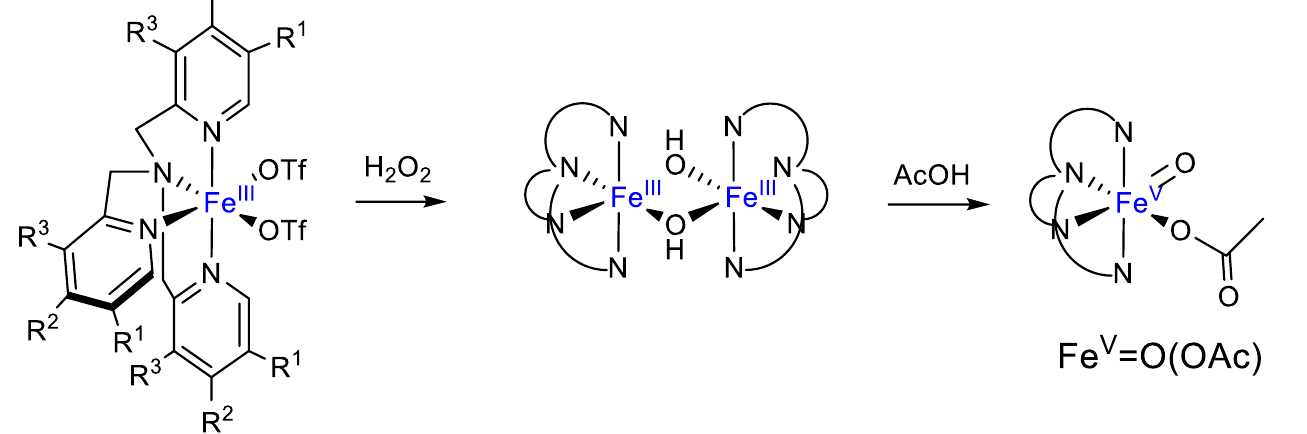
Figure 2. Selected compounds obtained by iron complex catalyzed oxidation.